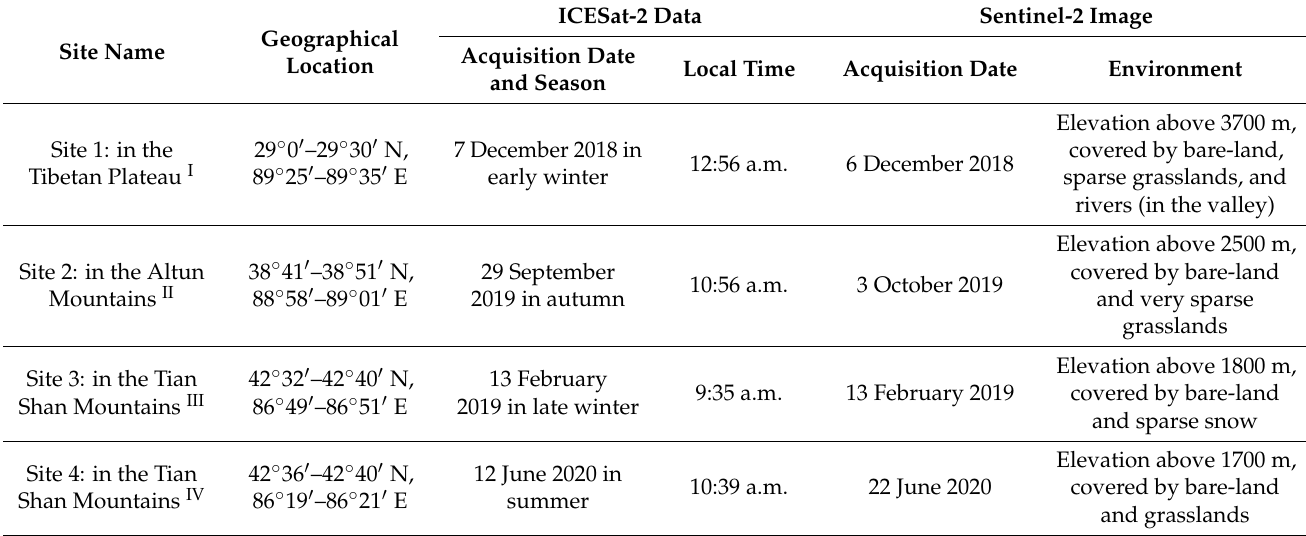
Table 1. Detailed information of the study areas and the used